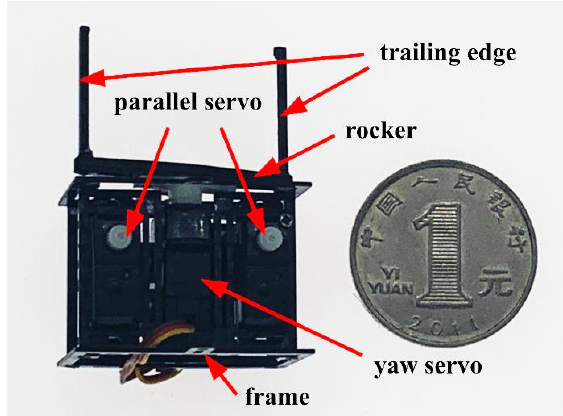
Figure 9. The physical drawing of the control